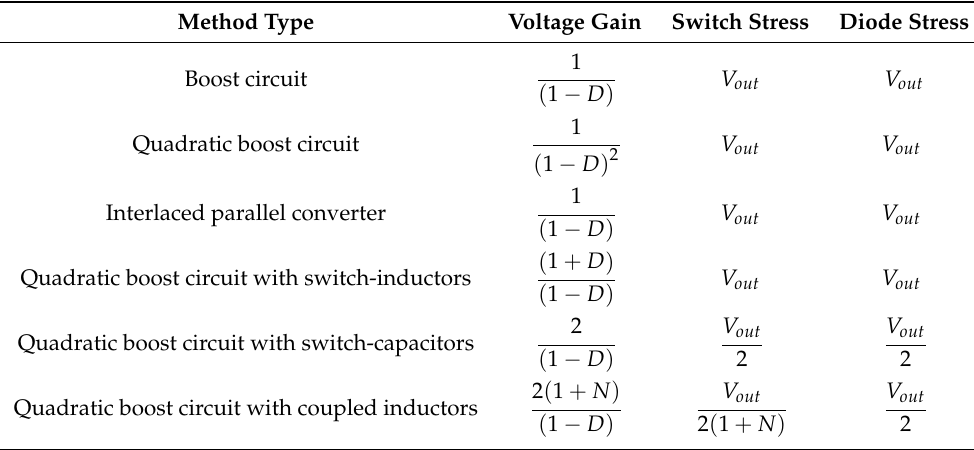
Table 1. The voltage gain, switch stress and diode stress in different